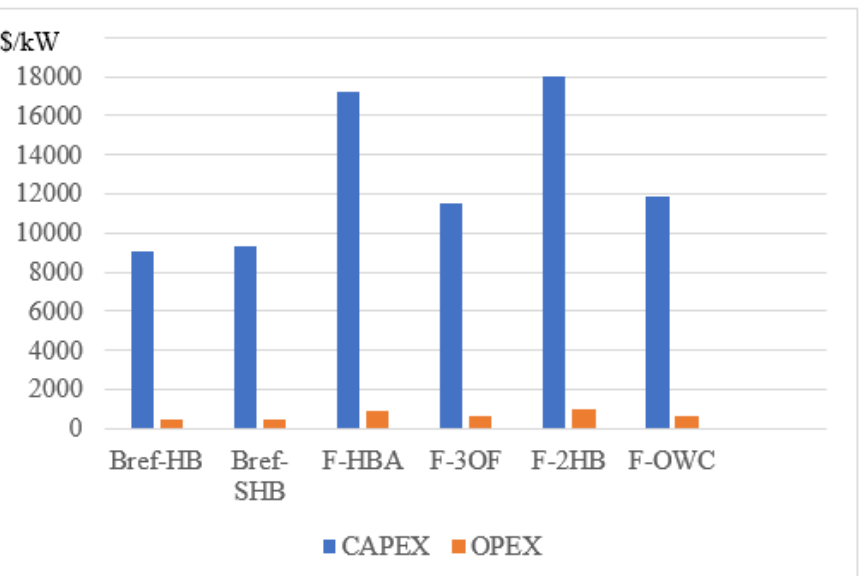
Figure 9. CAPEX per unit of case study located in the Norwegian Continental Shelf (Adapted with permission from Ref. [61]. 2019, Oliveira-Pinto, S., et al.).